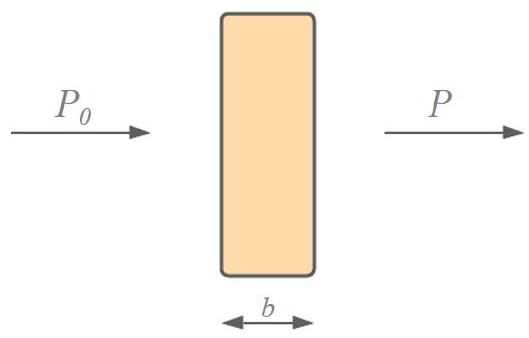
Figure 6. Schematic of light transmittance and absorbance.